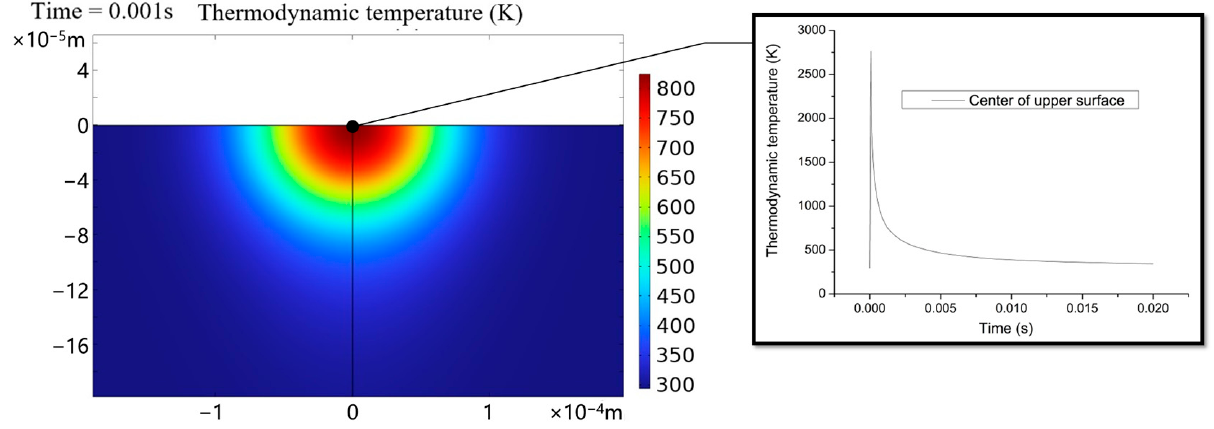
Figure 5. Thermodynamic temperature distributions of 0.001 s after laser irradiation, and thermodynamic temperature change curve at the center of the laser irradiation zone.